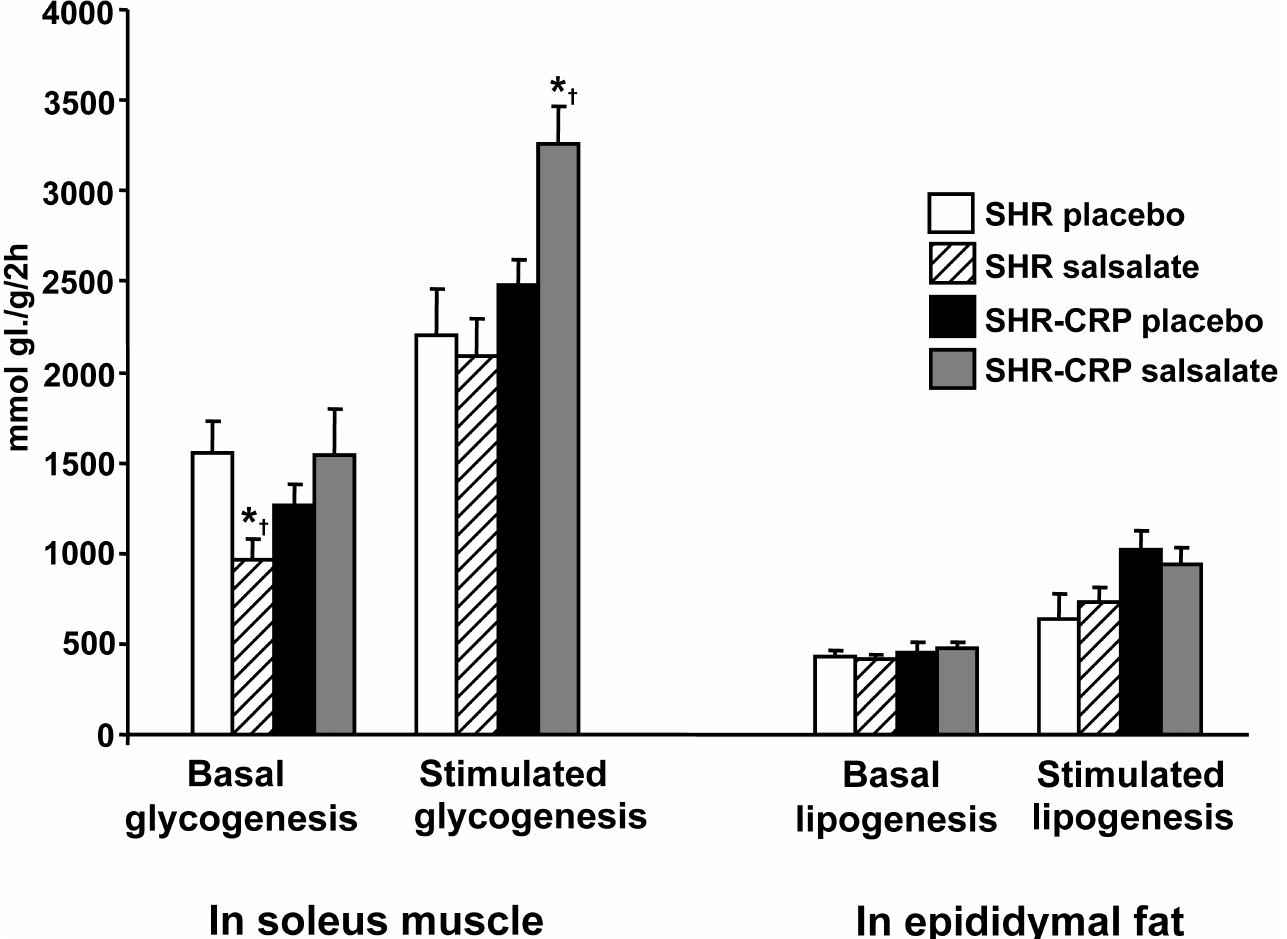
Fig 3. Basal and insulin-stimulated glucose incorporation into skeletal muscle glycogen (glycogenesis) and into lipids in epididymal fat (lipogenesis) in SHR and SHR-CRP rats treated with placebo or with salsalate. SHR-CRP rats treated with salsalateshowedsignificantly increasedsensitivity of skeletal muscle to insulinaction when comparedto nontransgenic SHR. No significanttreatment effects were observedfor basal- or insulin-stimulated lipogenesis. * denotessignificantdifferences(P < 0.05)betweenplaceboversus salsalate-treated groups; † denotes significantstrain x treatment interactions, i.e. salsalatetreatment protects againstthe adverseeffects of